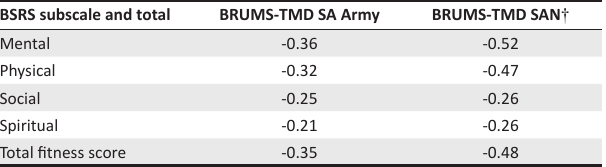
TABLE 6: Brief Sailor Resiliency Scale and Brunel Mood Scale correlations: South African Navy † and South African Army sample comparison. BSRS subscale and total